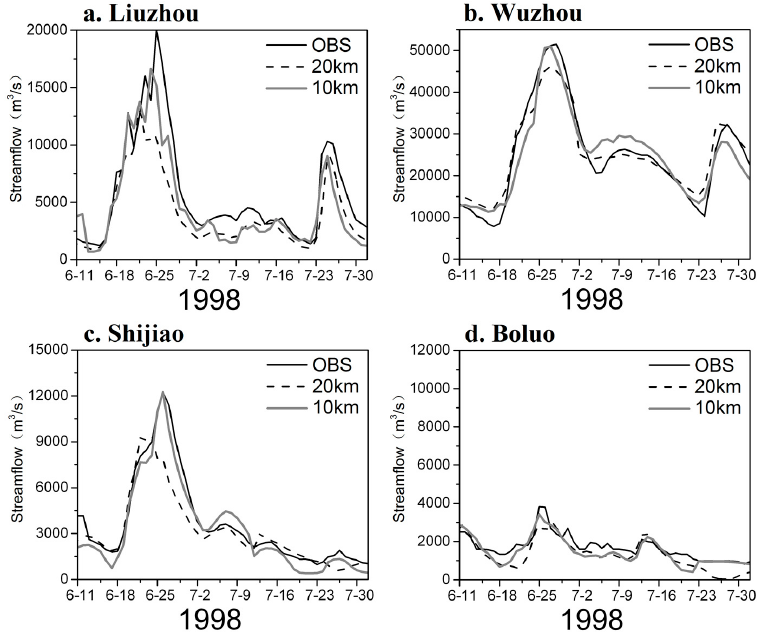
Figure 4. Flood simulation results for ( a ) Liuzhou; ( b ) Wuzhou; ( c ) Shijiao; and ( d ) Boluo Stations on the Pearl River in 1998. the Pearl River in 1998. Table 3. Evaluation of hydrological extremes simulation in 1998. Table 3. Evaluation of hydrological extremes simulation in